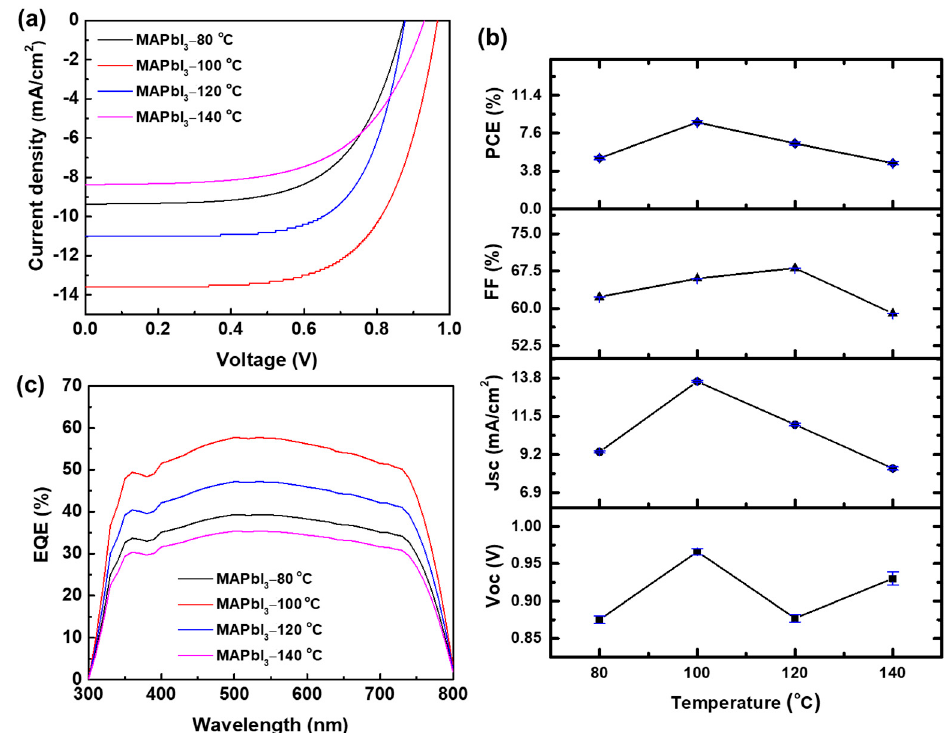
Figure 7. Device performance. ( a ) The illuminated J–V curves of the PSCs at annealing temperatures of 80, 100, 120, and 140 ◦ C under forward scan. ( b ) They represent the corresponding PCE, FF, Jsc, and Voc versus the temperatures at 80, 100, 120, and 140 ◦ C. (The error bars were calculated from 20 devices). ( c ) EQE spectra.